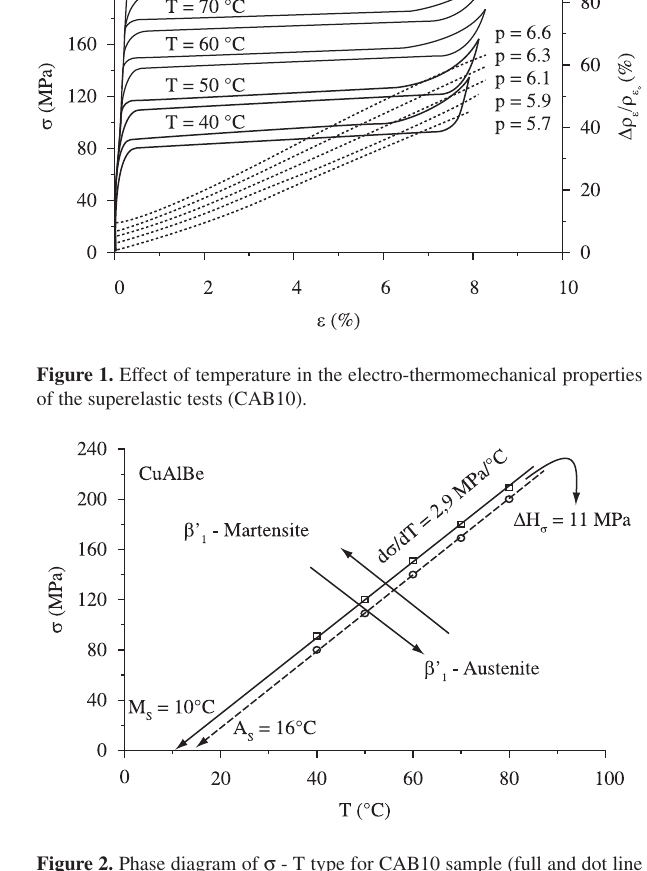
Figure 2. Phase diagram of σ - T type for CAB10 sample (full and dot line – direct and reverse transformation,